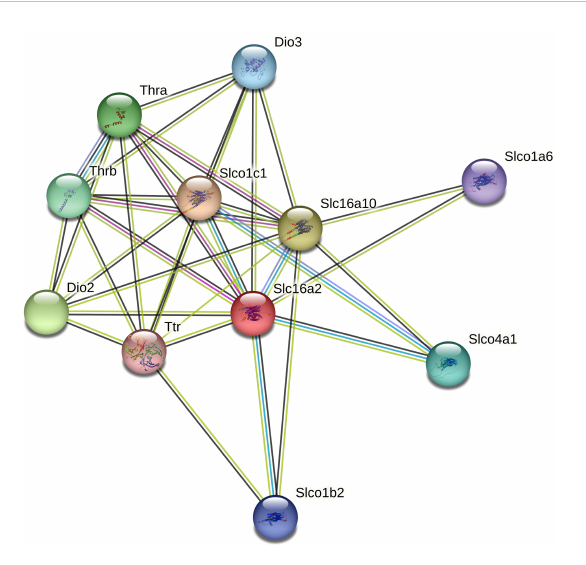
FIGURE 2 The protein-protein interaction network of Slc16a2. The protein- protein interaction analyses were performed using the STRING database. Shown are Slc16a2 (Solute carrier family 16 member 2 (Monocarboxylate transporter 8)) and its top 10 protein interactors (listed clockwise): Slco1c1 (Solute carrier organic anion transporter family member 1C1), Slc16a10 (Solute carrier family 16 member 10), Slco1a6 (Solute carrier organic anion transporter family member 1A6), Slco4a1 (Solute carrier organic anion transporter family member 4A1), Slco1b2 (Solute carrier organic anion transporter family member 1B2), Ttr (Transthyretin), Dio2 (Thyroxine 5- deiodinase type II), Thrb (Thyroid hormone receptors beta), Thra (Thyroid hormone receptors alpha), and Dio3 (Deiodinase, iodothyronine type III). Different line colors represent different types of interaction evidence between the